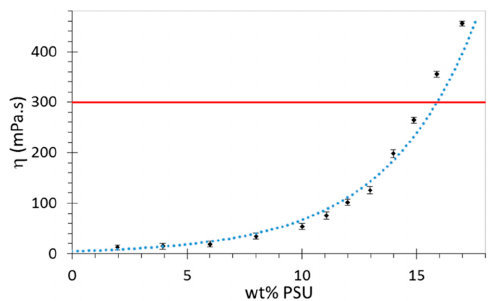
Figure 1. Viscosity curve of PSU solutions in N , N -Dimethylformamide (DMF) as a function of mass percent of PSU measured at 25 °C. The two-fluid nozzle theoretically only allows the spraying of solutions lower than 15 wt % (solid line).